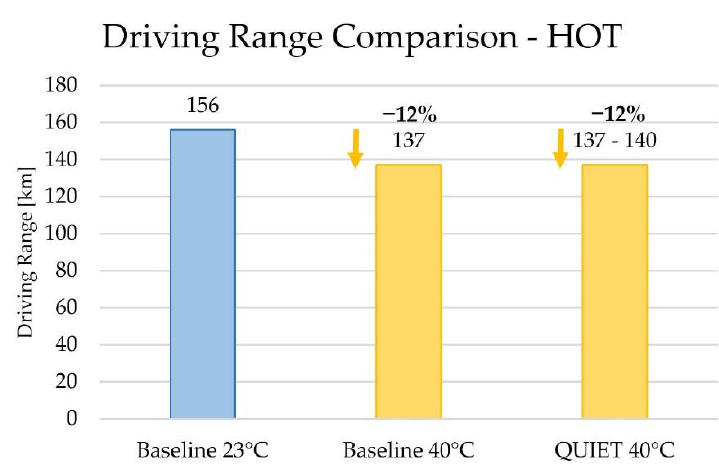
Figure 11. Driving range comparison at warm ambient temperature. Figure 11 . Driving range comparison at warm ambient temperature. Figure 11 . Driving range comparison at warm ambient temperature.